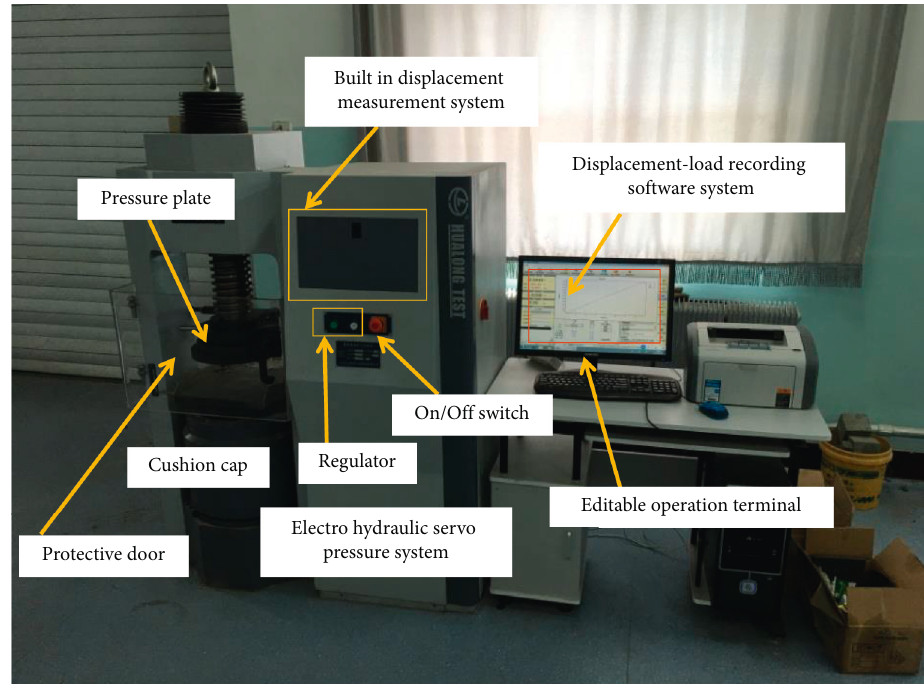
Figure 4: Load-displacement data acquisition